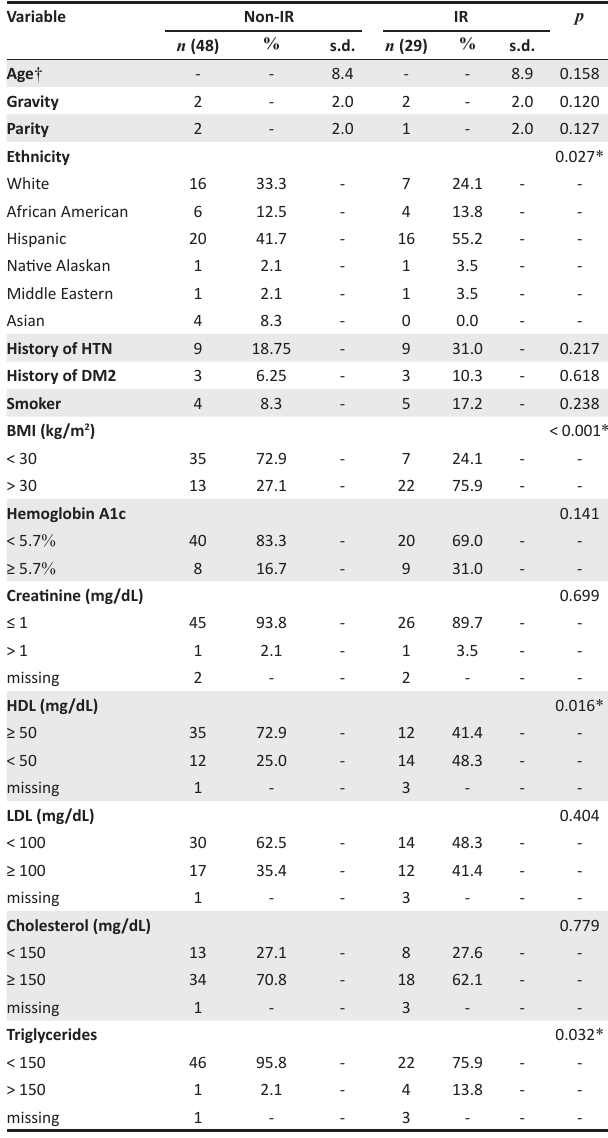
TABLE 2: Comparison of characteristics between IR and non-IR groups with IR defined as fasting insulin levels > 10 µiU/mL. Variable